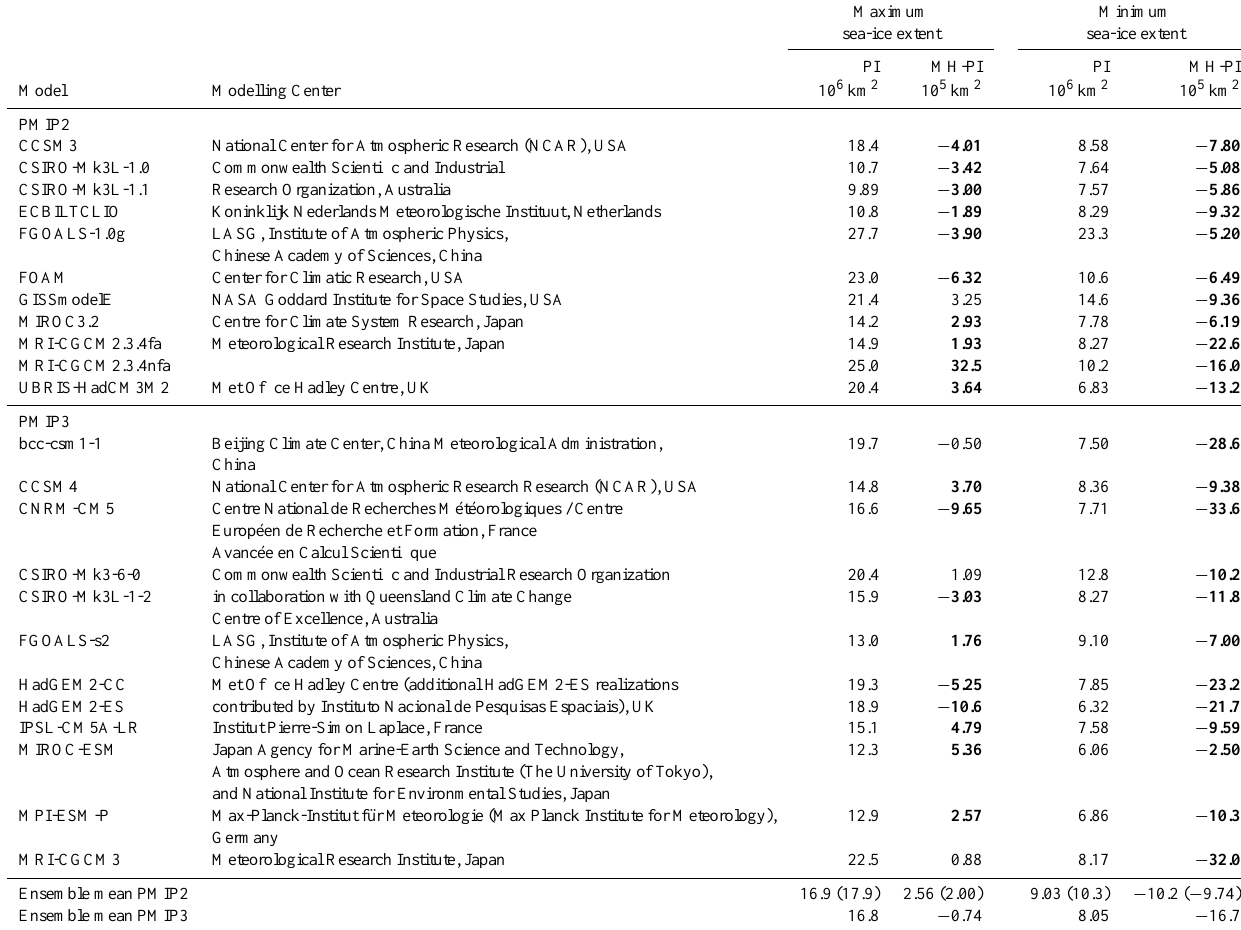
Table 1. Sea-ice extent in the month with minimum and maximum sea-ice extent for the PI and MH. A grid cell is considered covered with sea ice if the sea-ice concentration is larger than 15%. The models with statistically significant changes between MH and PI are marked boldface. The ensemble mean for PMIP2 are excluding (including) FGOALS. All models simulate significantly reduced minimum sea-ice extents, and almost all simulate significant changes in the maximum